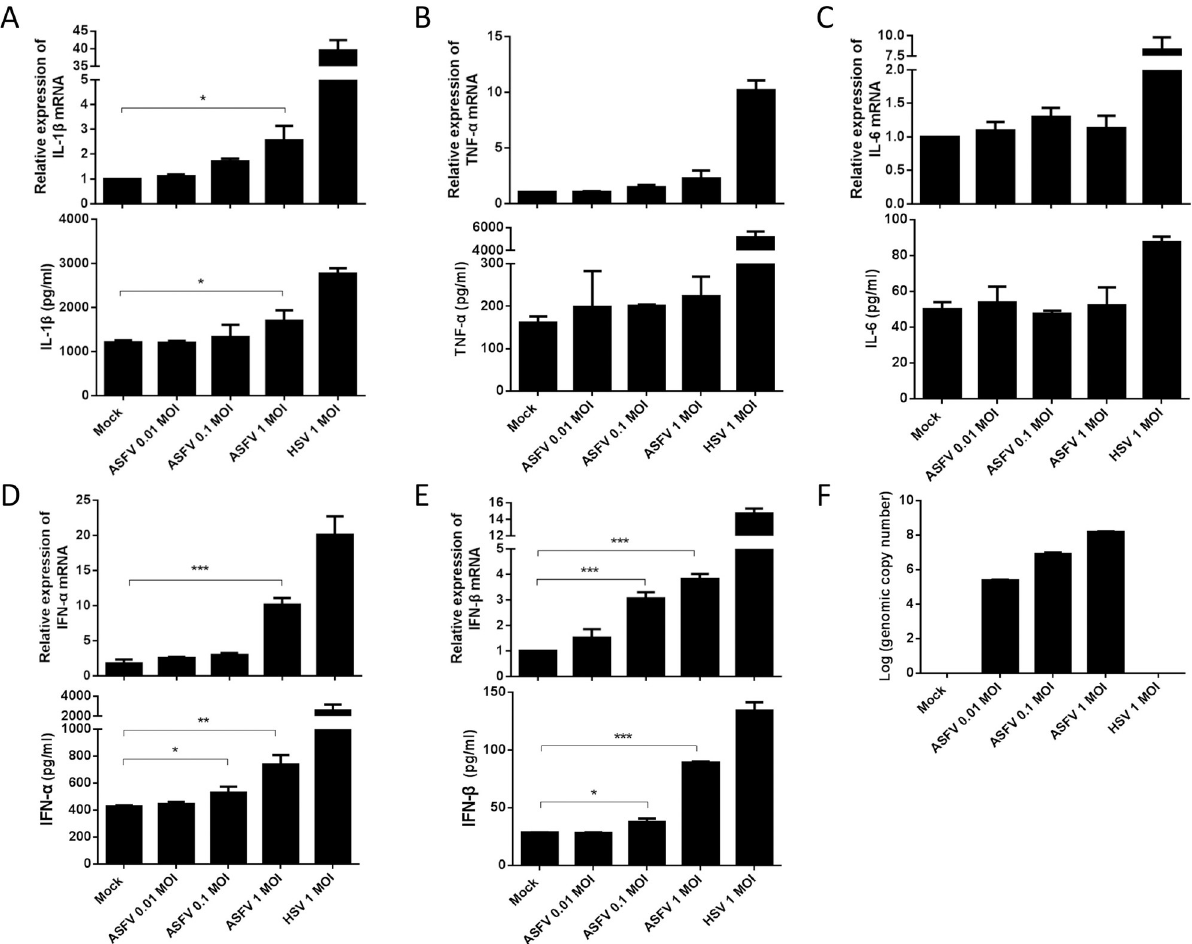
Fig 1. ASFV infection induces low levels of IL-1 β and type I IFN in PAMs. (A-E) PAMs were either mock-infected or infected with ASFV at an MOI of 0.01, 0.1, and 1.0, respectively. At 24 hpi, the IL-1 β (A), TNF- α (B), IL-6 (C), IFN- α (D) and IFN- β (E) levels in the cell culture supernatants were detected by ELISA and the mRNA levels in the cell lysates were determined by qPCR. PAMs were infected with HSV-1 at an MOI of 1.0 as a control. The genome copy numbers of ASFV in PAMs were measured by qPCR (F). A p value of less than 0.05 was considered statistically significant. � p < 0.05, �� p < 0.01, ��� p <